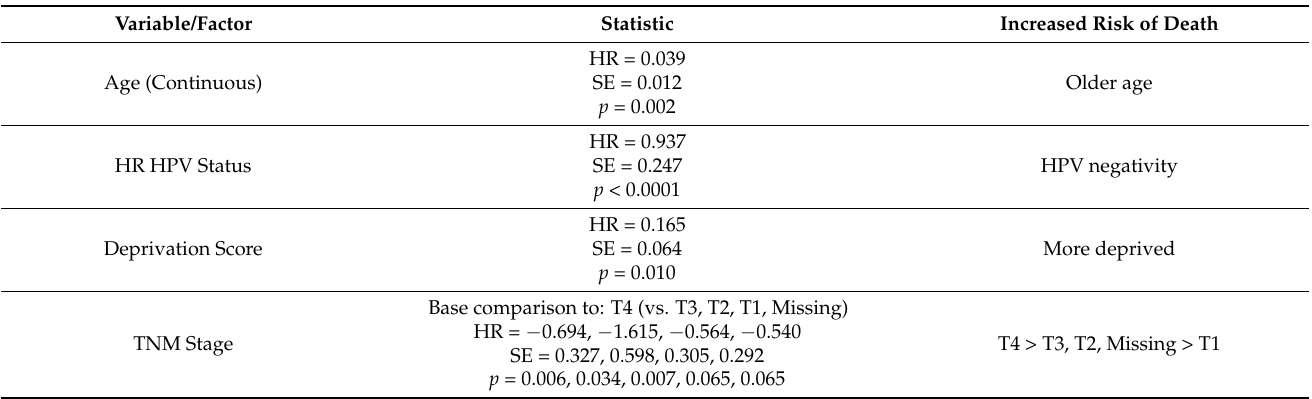
Table 7. Patient and tumor characteristics significantly predicting disease-specific (cancer-specific) survival amongst oropharyngeal cancer patients by multivariable Cox proportional hazard model ( n = 209).